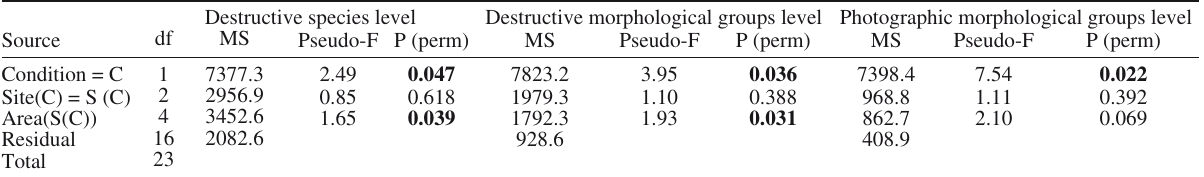
Table 1. – Results of PERMANOVA analyses on coralligenous assemblages subjected to different conditions obtained through destructive and photographic sampling methods. Results of the destructive samples referred both to the species and morphological groups levels of determination. Significant effects are in bold.